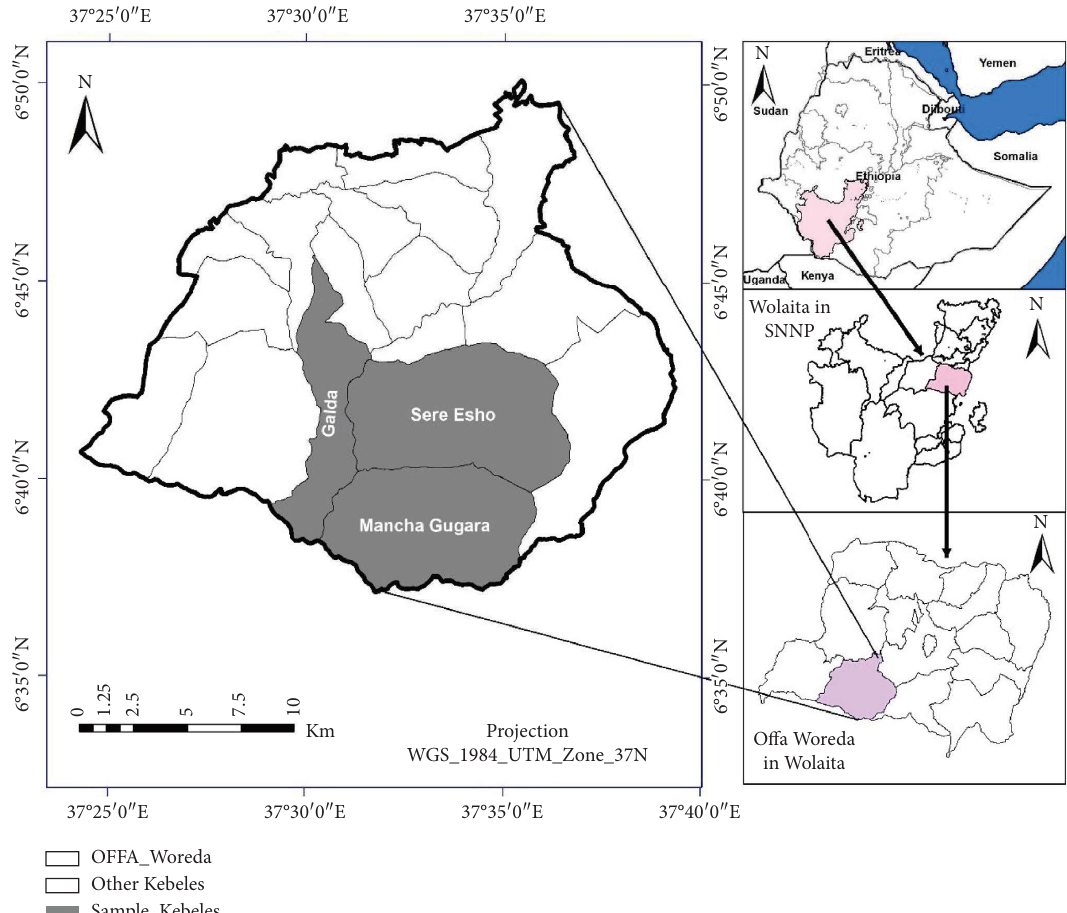
Figure 1: Location of the study area (source: author